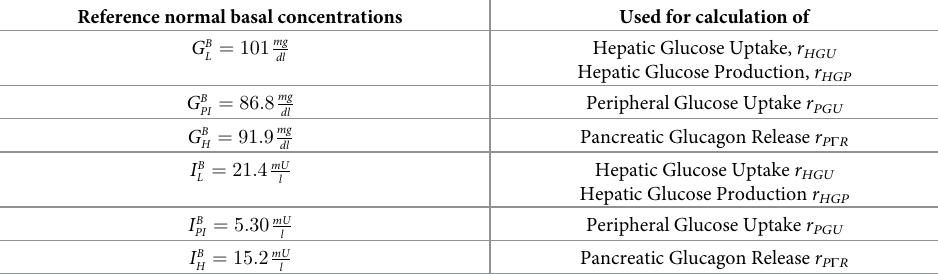
Table 1. Reference normal basal state glucose and insulin concentrations used to fix the concentration scales defining normal metabolic source and sink rates. Reference normal basal